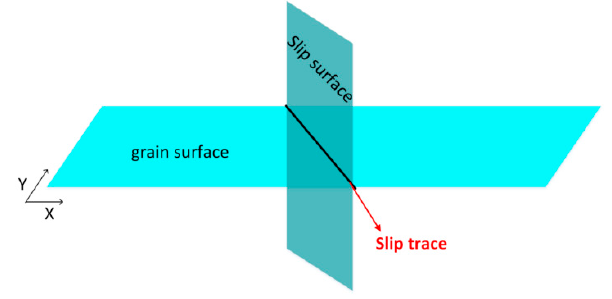
Figure 4. Schematic diagram of slip trace.